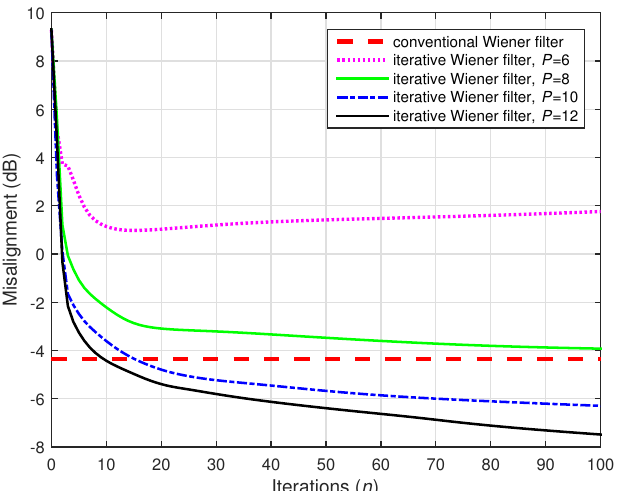
Figure 24. Performances of the conventional and iterative Wiener filters, using N = 10,000. The source signal (white Gaussian noise) was preprocessed with positive and negative half-wave rectifiers, using α = 0.1. The numbers of channels were M = 2 (stereophonic scenario), L = 1024, and SNR = 30